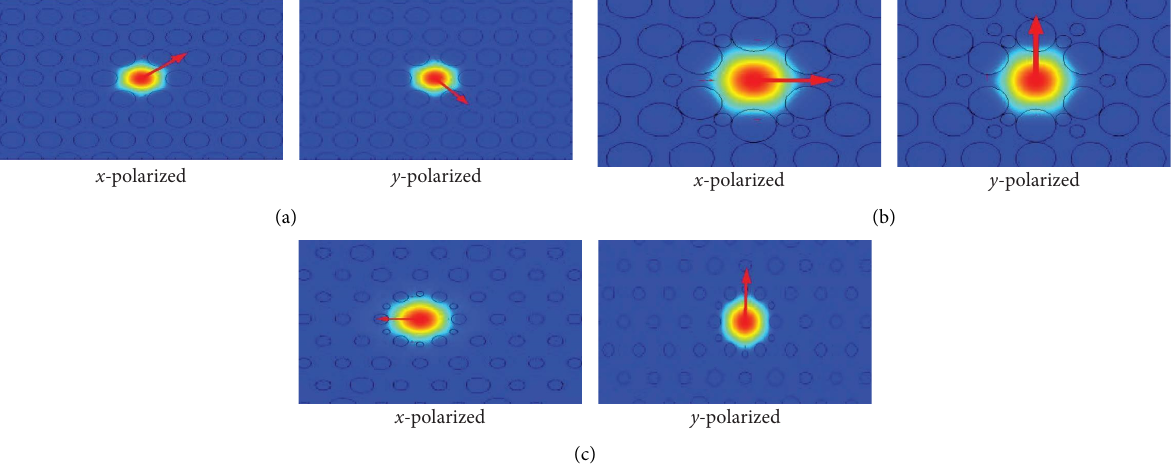
Figure 4: X-Y polarization of the fundamental mode profles of DC-PCF at λ � 1.55 µ m.